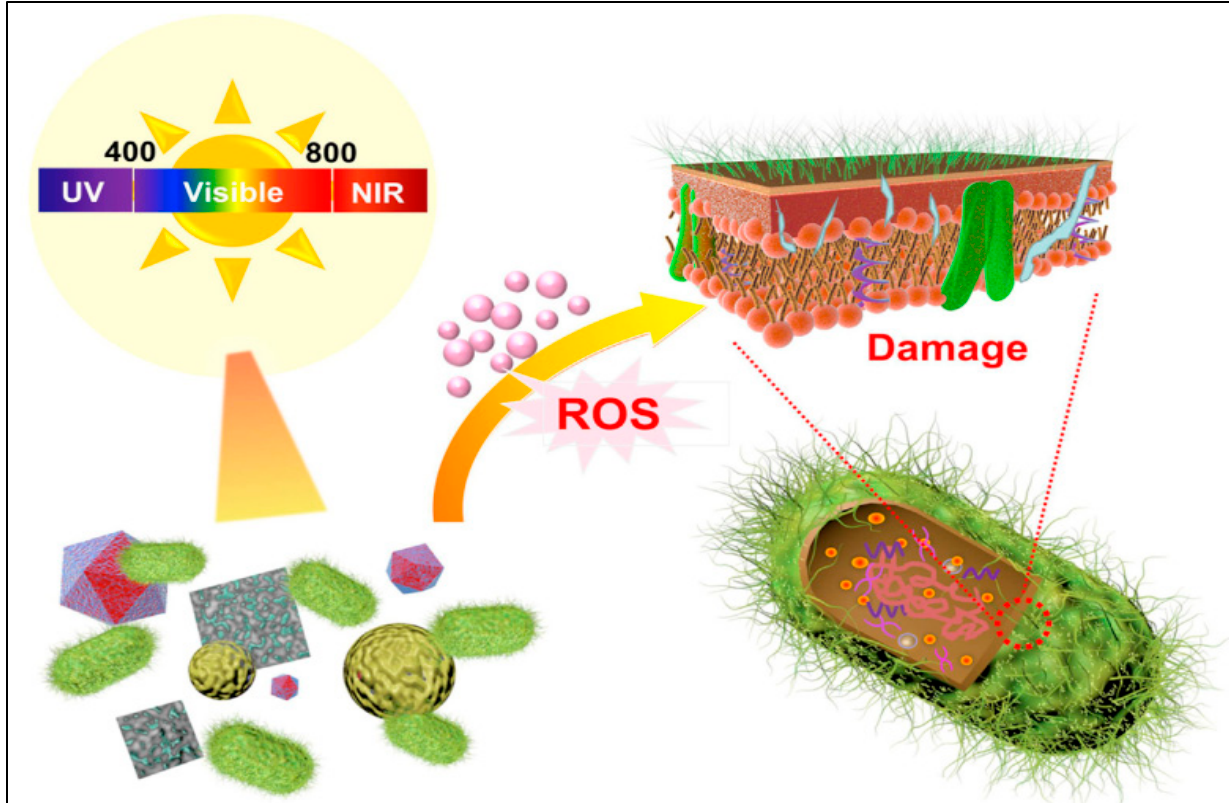
Figure 2. Photo-antibacterial activity of nanomaterials. The image was reproduced with permission [48]